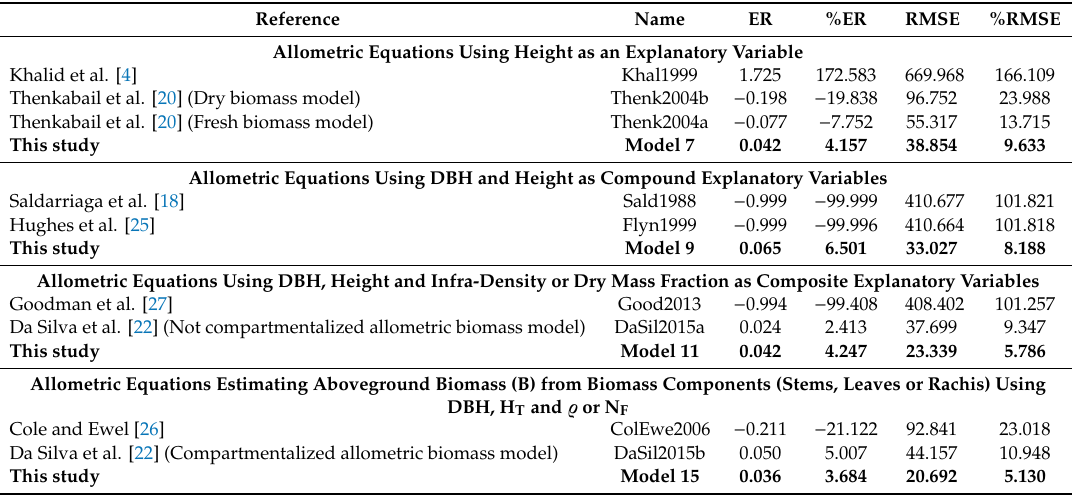
Figure 5. Comparison of the selected existing allometric models with the best allometric models that were proposed in this study: ( a ) biomass variation according to DBH; ( b ) relative error variation according to DBH. Table 8. Comparison of the existing allometric biomass models to the corresponding local models that were developed in this study.